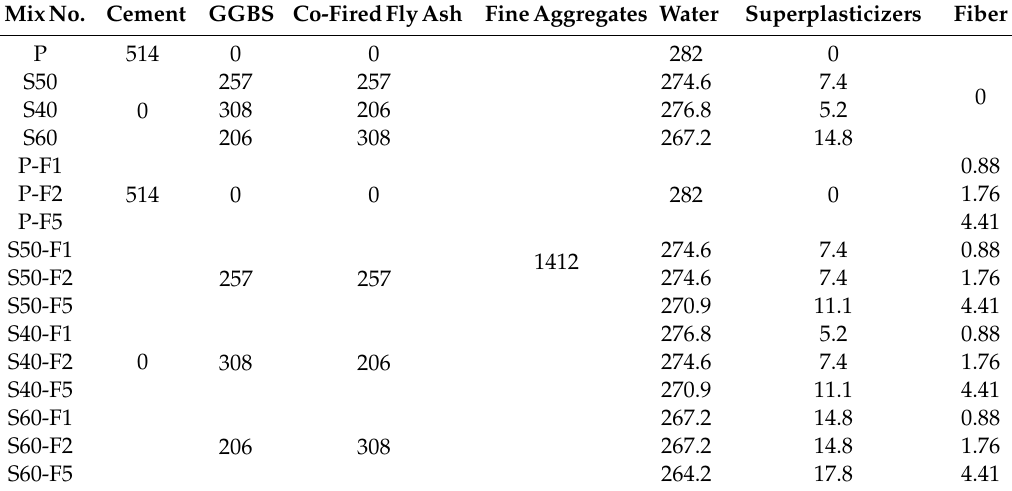
Table 2. Mix design of the mortar specimens produced (kg / m 3 ).